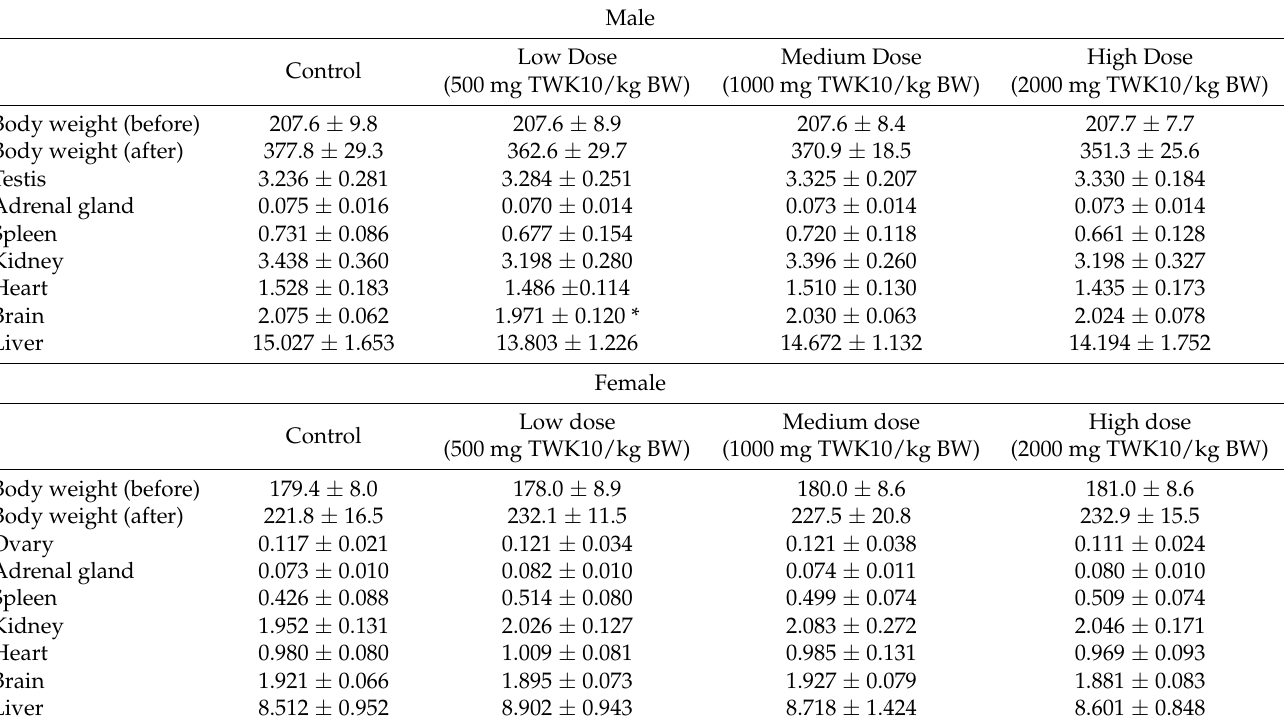
Table 6. Body weight and organ weight of Sprague–Dawley rats administered TWK10 for 28